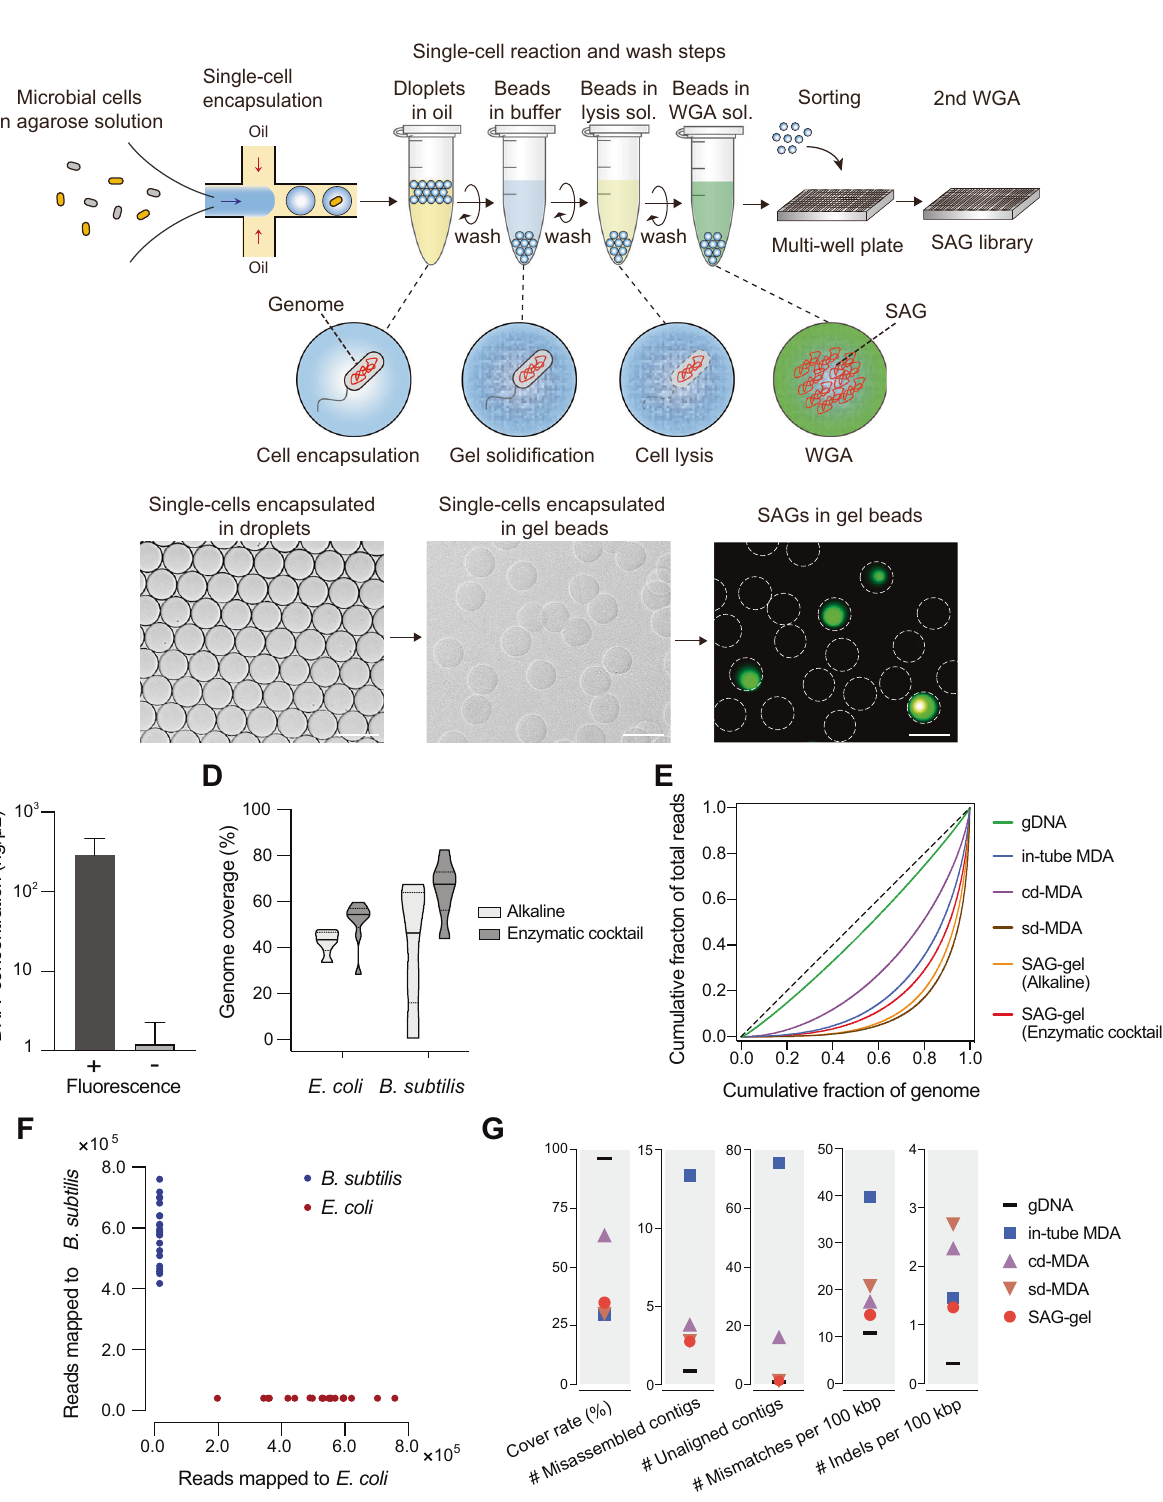
RS1 and RS2 was considered, estimated genome sizes and the number of CDSs (3.1 Mbp and 3183 in HIMB11, respectively) were comparable to each other. However, genome alignment revealed that 86.81% and 70.04% of the RS1 and RS2 genome sequences respectively exhibited ≤ 75% nucleotide identity to that of HIMB11 (Fig. S3B, C). ANI of the whole genome was 91.7% (RS1 – RS2), 91.4% (RS1 – HIMB11), and 92.4% (RS2 – HIMB11).